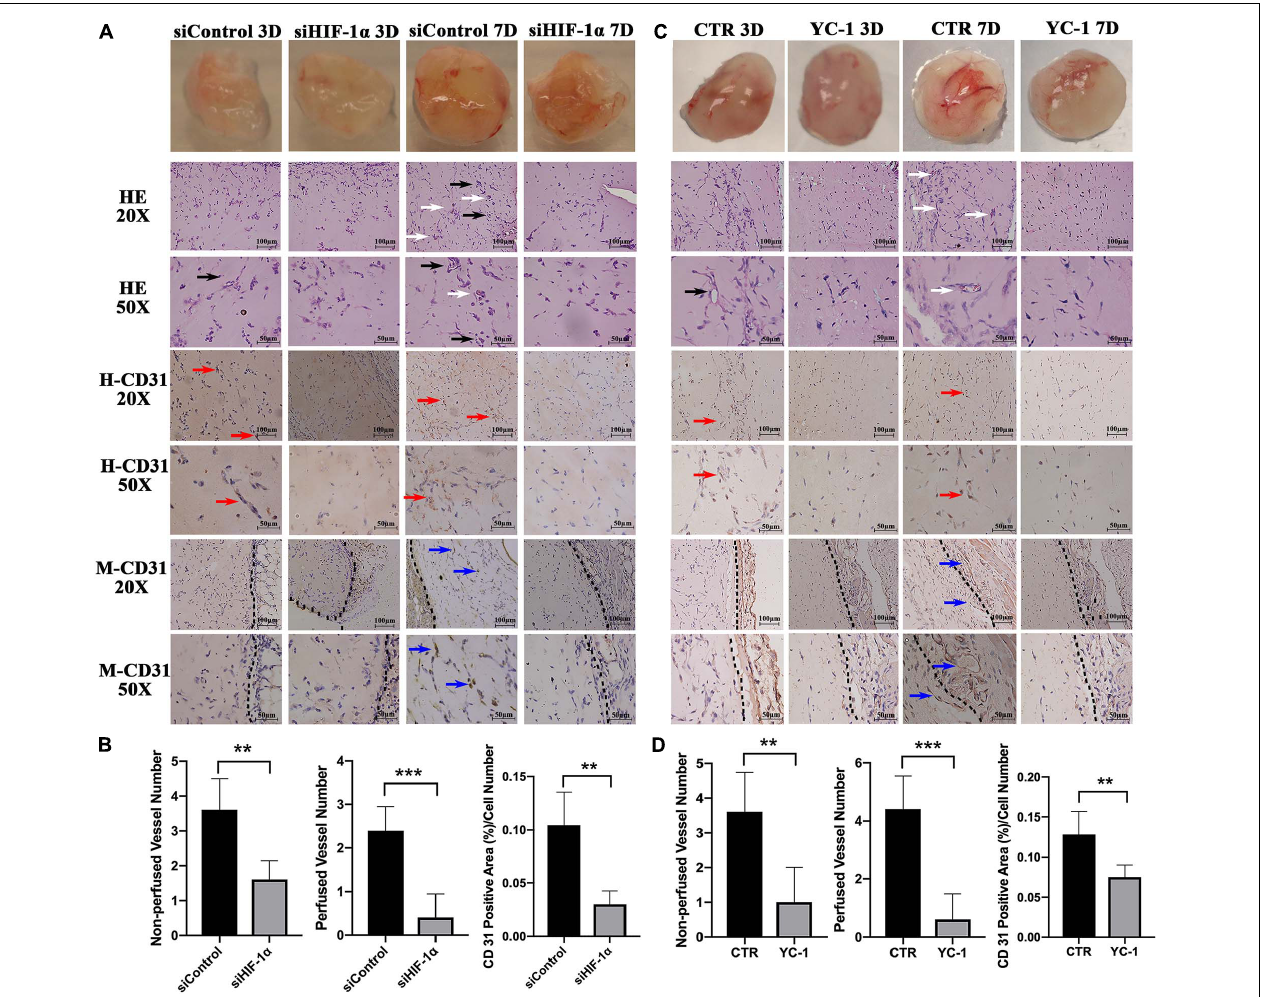
FIGURE 3 | Silencing or chemical inhibition of HIF-1 α expression impairs the angio-/vasculogenic capacity of SHED. Macroscopic photos, H&E staining, immunohistochemical staining for human CD31 and mouse CD31 of (A) siControl SHED and siHIF-1 α SHED (C) CTR SHED and YC-1 SHED Matrigel plugs 3 days and 7 days after implantation. Quantified graphs of non-perfused and perfused vessel numbers and percentages of human CD31 positive area of (B) siControl SHED and siHIF-1 α SHED (D) CTR SHED and YC-1 SHED Matrigel plugs at 7 days after implantation. Black arrows – non-perfused vessel-like structures, White arrows – perfused vessels, Red arrows – human CD31 positive vessel-like structures, Blue arrows – mouse CD31 positive vessel-like structures, and Black dotted line – the boundary between Matrigel plug and mouse tissue. ** p < 0.01, and *** p < 0.001. Scale bar: 20 × = 100 µ m, 50 × = 50 µ